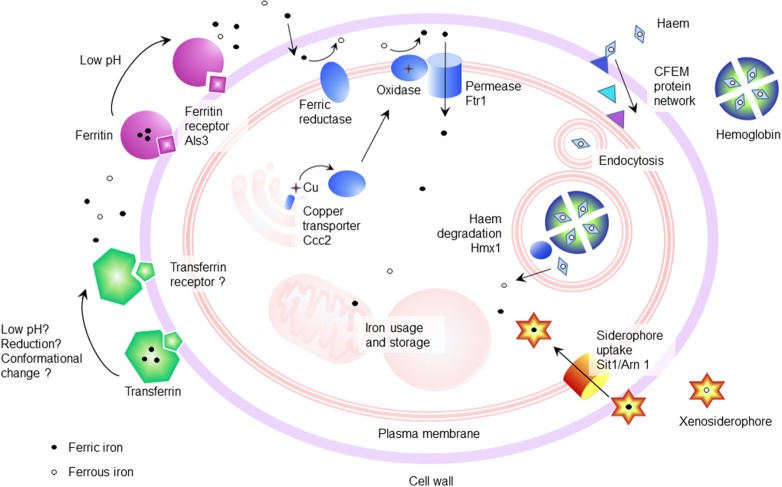
Schematic of the iron uptake mechanisms of Candida albicans. Iron can be acquired from host iron binding proteins such as hemoglobin (Kuznets et al., 2014), ferritin (Almeida et al., 2008), and transferrin, as well as from free iron through the action of the reductive iron uptake pathway (Knight et al., 2002, 2005). In addition, the siderophore uptake system (Sit1/Arn1) functions in iron acquisition from xenosiderophores (Heymann et al., 2002).